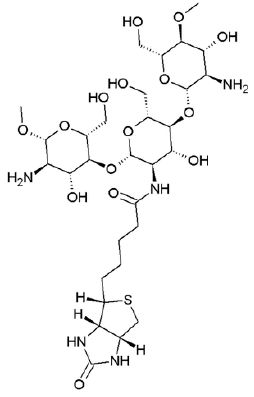
Figure 7. Biotinylated chitosan.